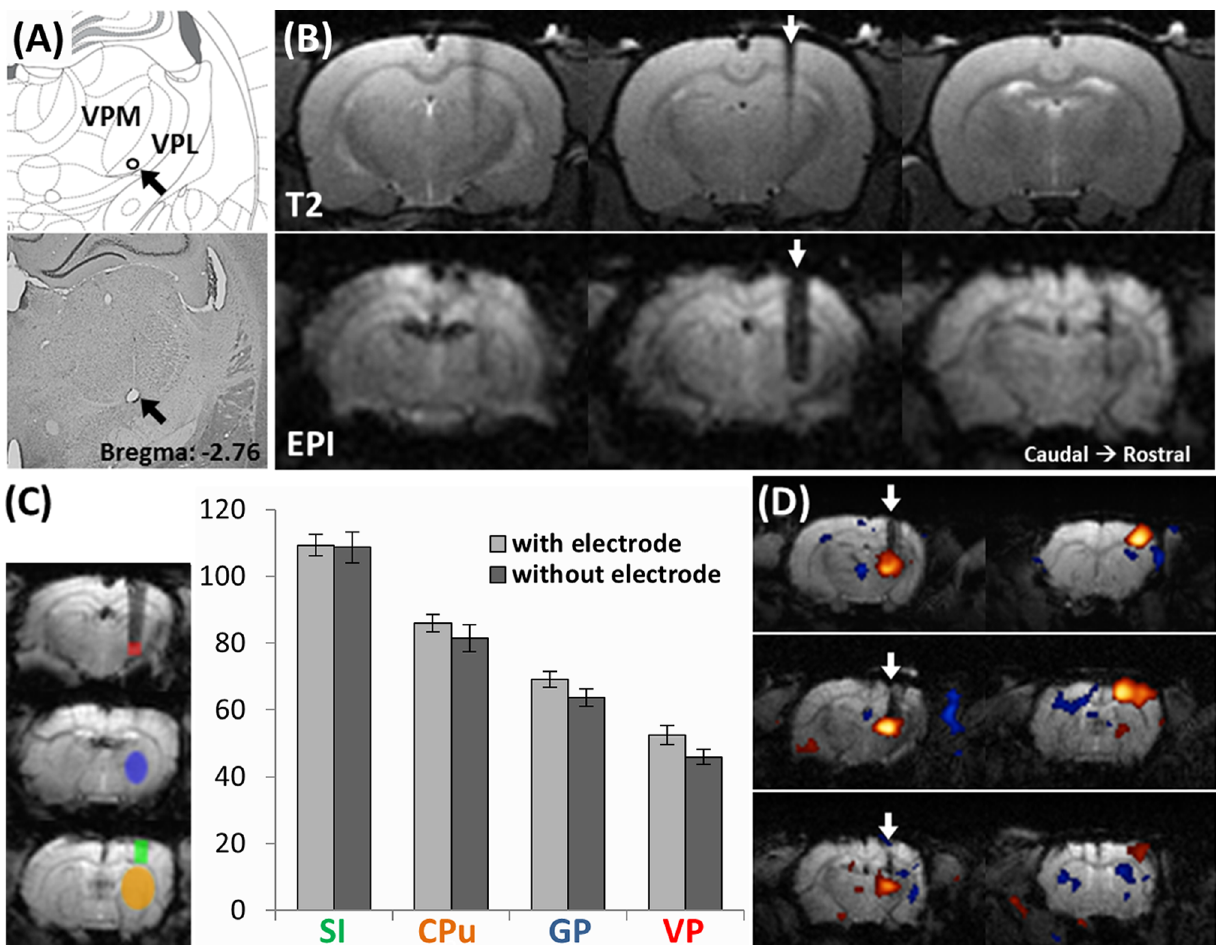
Figure 3. Evaluation of image distortion caused by tungsten electrode. (A) An example of the identification of the electrode target site by cresyl violet stained brain section. The lesion at the electrode tip (black arrow) was produced by a constant electric current of 30 m A for 30 s before euthanizing the animal. The electrode lesion was located within the forepaw region of the VPL thalamus. (B) The tungsten electrode caused limited distortion to the MR signal around the electrode in T2 anatomical images (upper panel) and in EPI images (lower panel). In each panel, 3 serial scans from caudal (left) to rostral (right) are shown. The white arrows indicate the electrode track. (C) SNR in different brain areas in control rats and rats implanted with a tungsten electrode. The ROIs were defined as shown in the left panel: VP thalamus=red, globus pallidus (GP)=blue, caudate putamen (CPu)=yellow and S1=green. In all 4 brain areas, no significant difference between the tungsten electrode compared with the control was observed. (D) Representative DBS-fMRI results from 3 individuals. White arrows indicate the electrode tracks. Positive BOLD response can be clearly observed in the VP thalamus and ipsilateral S1. We evaluated the distortion caused by the tungsten electrodes to the images. Figure 3B shows the representative T2 anatomical images (upper panel) and EPI images (lower panel) around the electrode. In each panel, 3 serial scans from caudal (left) to rostral (right) are shown; the middle image depicts the electrode implant site. The distortion caused by the tungsten electrode to the MR signal around the electrode site, in both the T2 anatomical images and the EPI images, was limited. SNRs were not observed to be significantly attenuated in S1 (Ctrl: 109 6 5, Elec: 109 6 3), CPu (Ctrl: 86 6 4, Elec: 81 6 3), or GP (Ctrl: 69 6 3, Elec: 64 6 2). SNRs